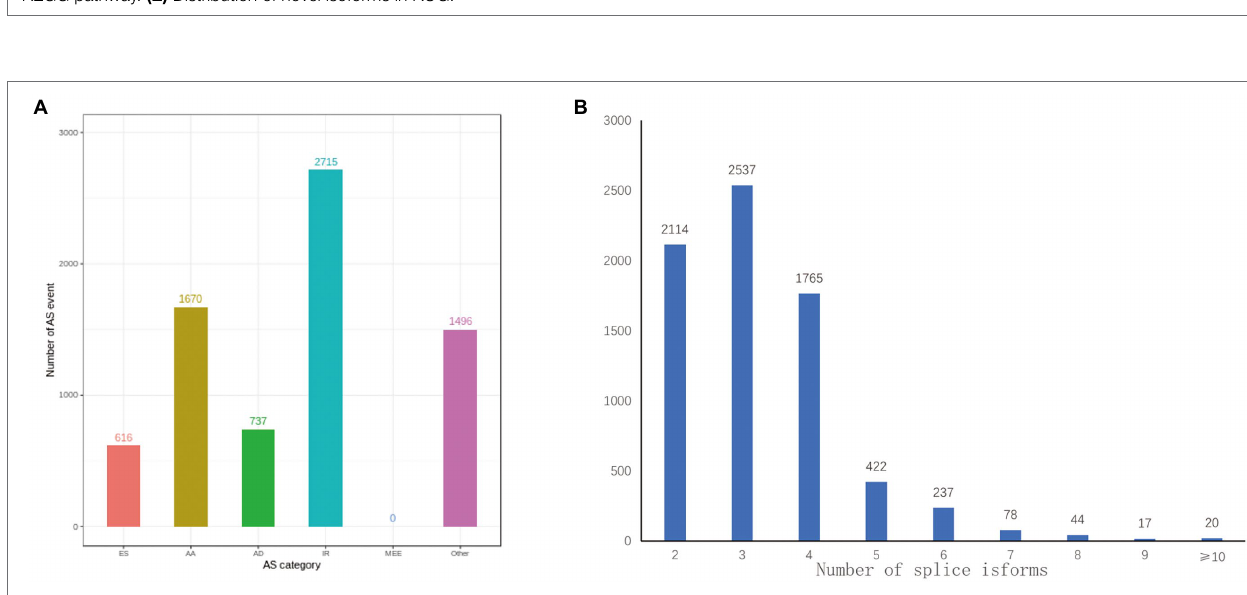
FIGURE 5 | Function annotations of novel isoforms identified by the PacBio Sequel platform. (A) The number statistics of novel isoforms in NR GO, KEGG, KOG databases. (B) Distribution of novel isoforms in Nr homologous top 10 species. (C) Distribution of novel isoforms in GO terms. (D) Distribution of novel isoforms in KEGG pathway. (E) Distribution of novel isoforms in KOG.